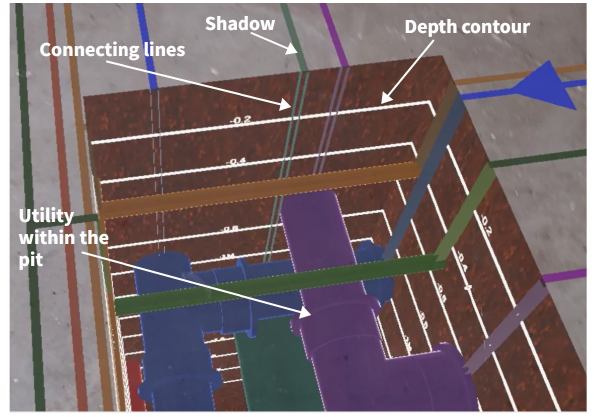
Figure 13. X-Ray Box View